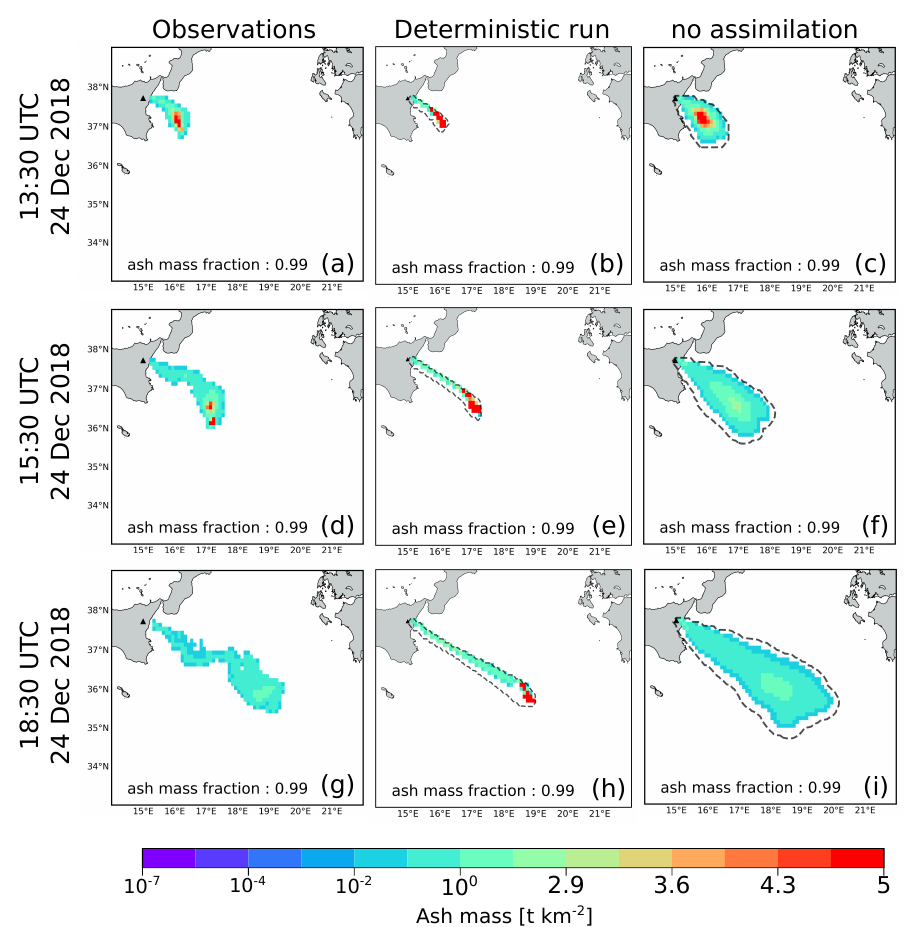
Figure 4. Comparison between the observed ash cloud and the results of PLUME-MoM&HYSPLIT simulations done without DA. Panels ( a , d , g ) show the cloud as seen from space, while Panels ( b , e , h ) report the results of a deterministic simulation initialized with the input parameters of Table 2 and performed using the reference wind-field. Panels ( c , f , i ) present the outcomes of an ensemble simulation performed using the setting of